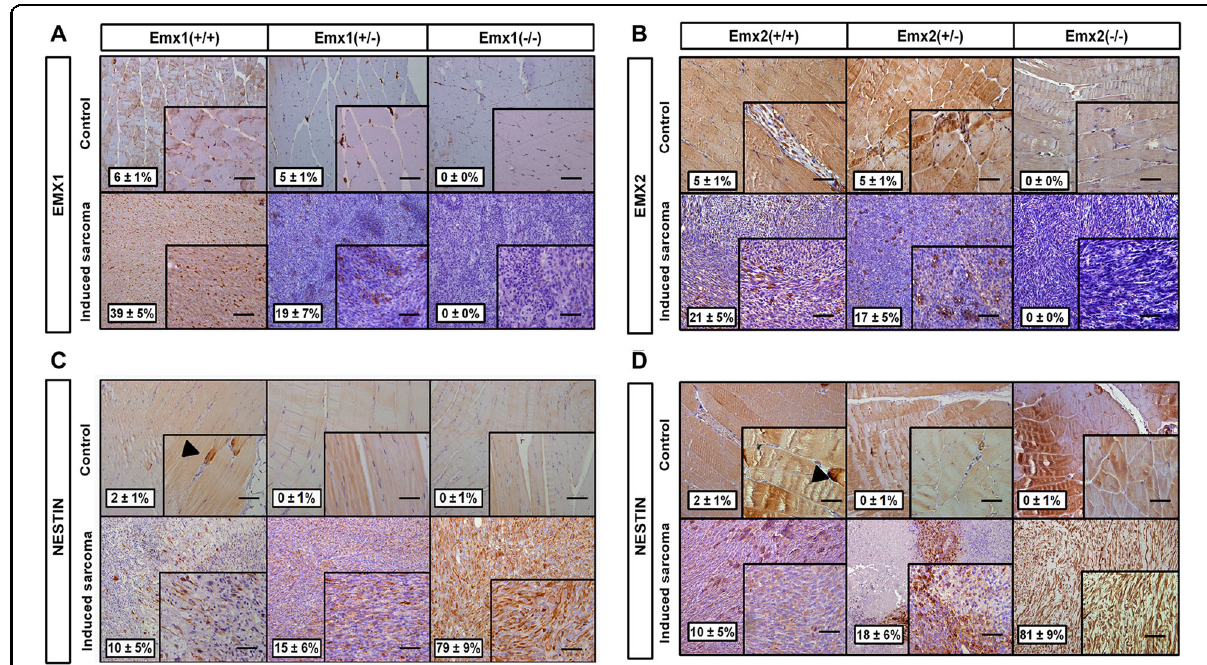
Fig. 6 Immunophenotypic characterization of EMX1 and NESTIN in sarcomas obtained by induction of 3MC in the Emx KO mice. The results of immunohistochemistry against the transcription factor EMX1 ( A ) and EMX2 ( B ), and the neural lineage marker NESTIN in the EMX1 KO cell line model ( C ) or EMX2 KO model ( D ). The upper panel of each section shows micrographs of the control muscle tissue section at ×200 magni fi cation and the lower panel shows micrographs of the 3MC-induced sarcoma in the Emx model. The arrow indicates a NESTIN-positive cellular immunostaining detail. The image in the lower right corner of each micrograph is ×400 magni fi cation. The bar indicates 200 µm. The percentage of mean cell immunolabeling measured in fi ve fi elds per replicate ± the SD was monitored. Immunohistochemistry was performed in a minimum of three replicates for each tumor